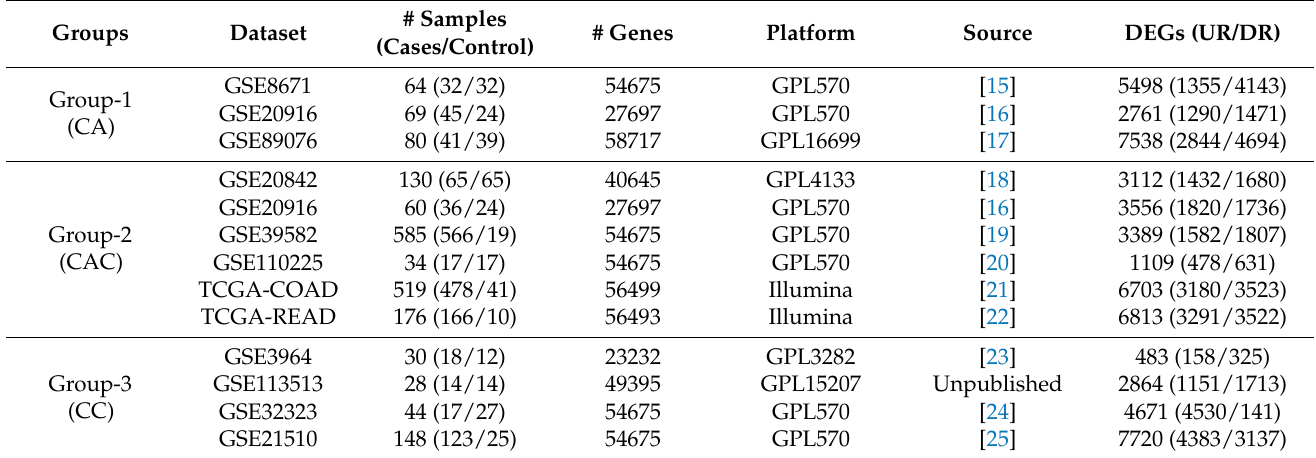
Table 1. Description of the datasets used in the